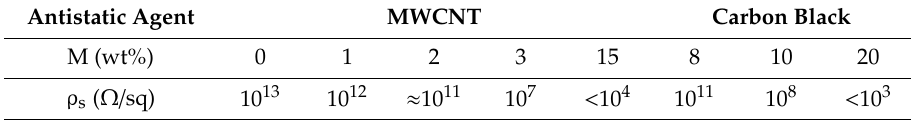
Table 3. The surface resistivity of PA1012/multi-walled carbon nanotubes (MWCNTs) composites. Antistatic Agent MWCNT Carbon Black